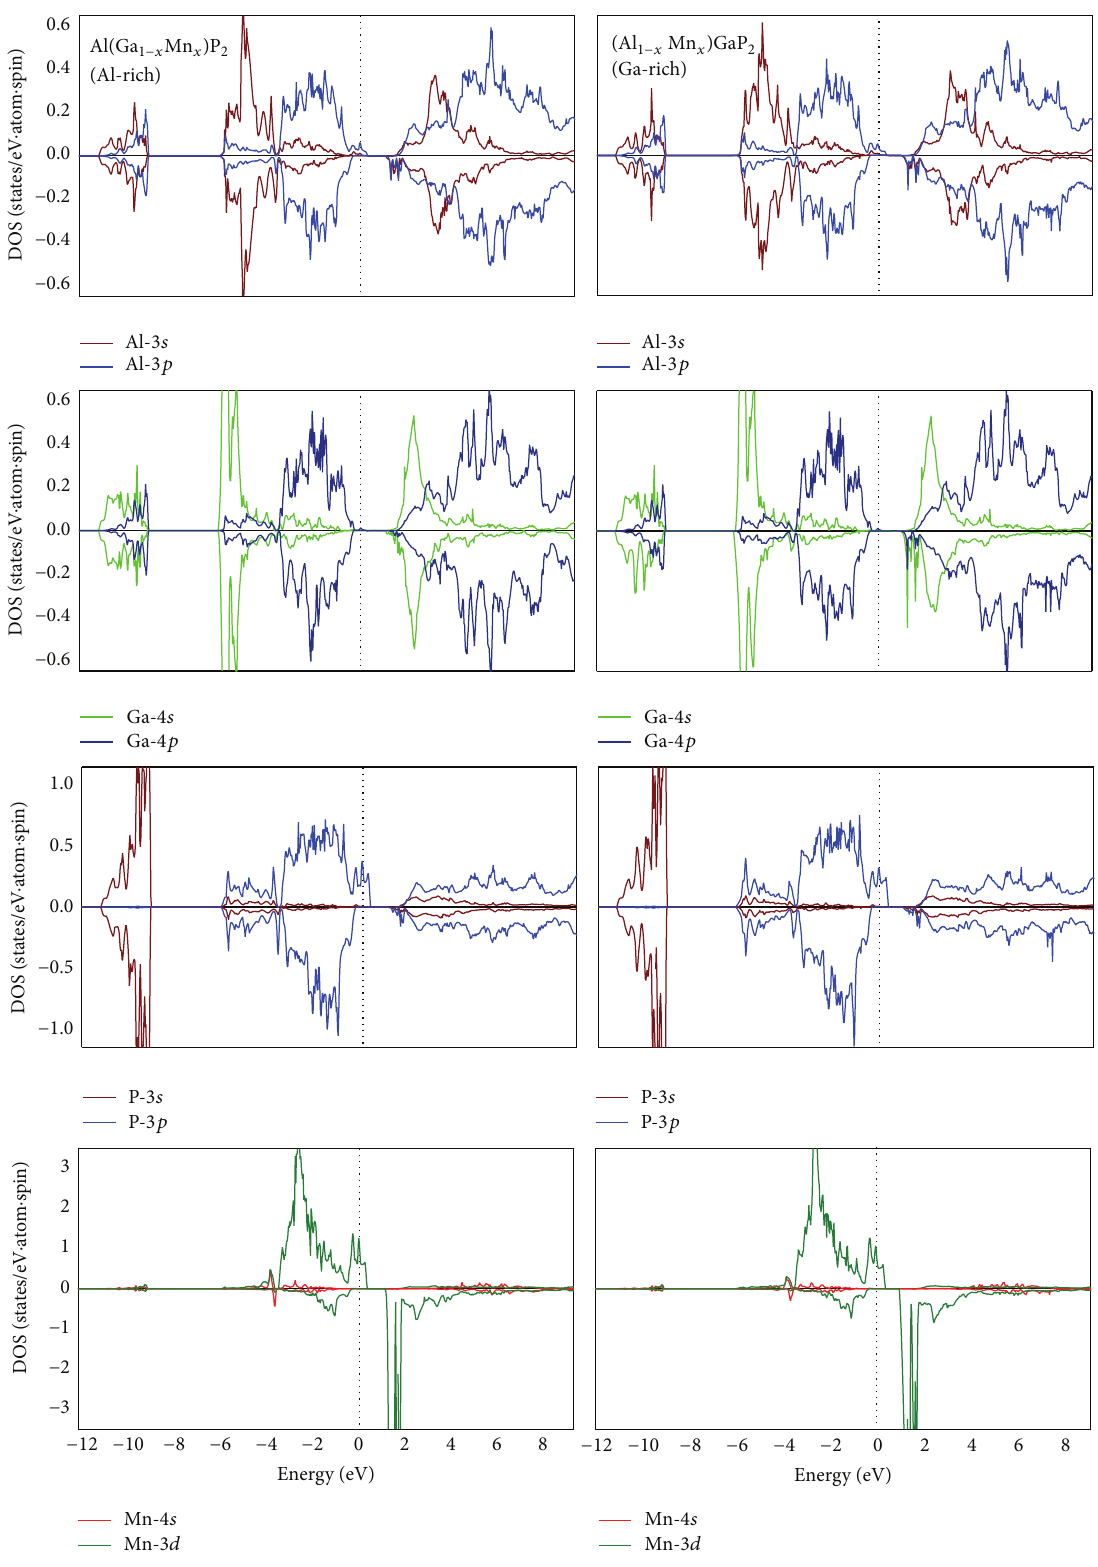
Figure 2: DOS for Al, Ga, P, and Mn sites of 3.125% Mn-doped AlGaP 2 in the FM state. The Fermi level is set to